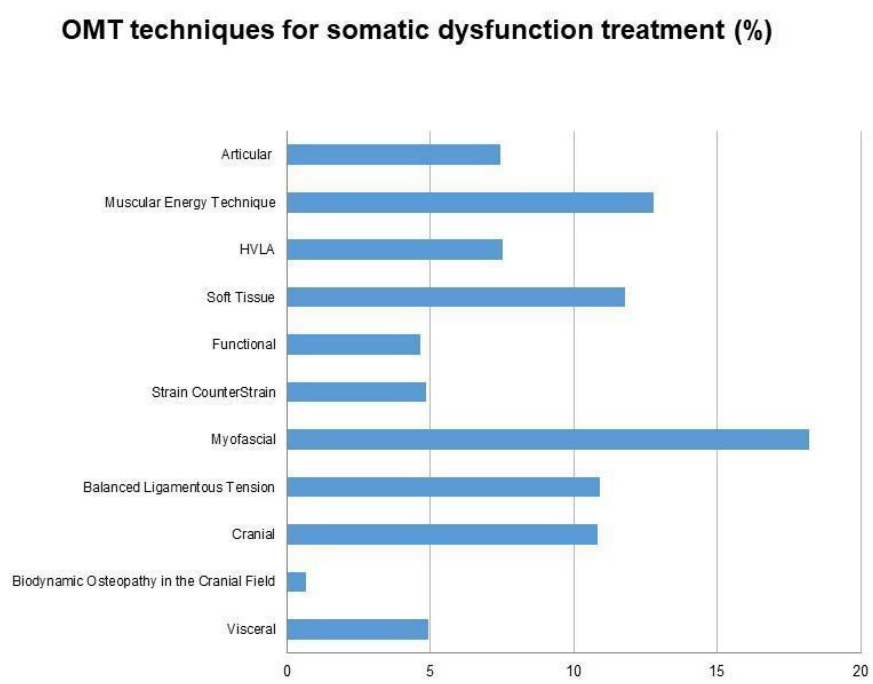
Figure 4. OMT techniques used for the treatment of somatic dysfunction across the studies included in the review. OMT = Osteopathic Manipulative Treatment.